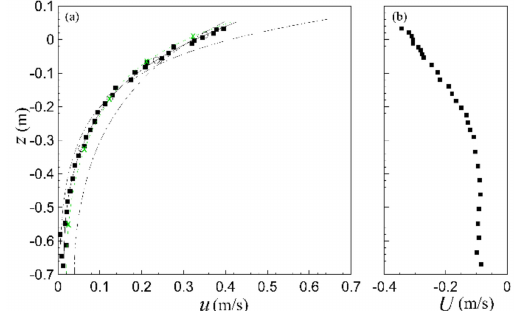
Figure 16. ( a ) The vertical distribution of horizontal velocity and ( b ) measured current profile for non-linear waves interacting with positively sheared following current: experimental data (squares), FNHS mode (solid lines with circles), QNHS mode (dashed lines with X marks), the wave-only solution (dash-dotted lines), and the Doppler-shifted solution (dash-dot-dotted